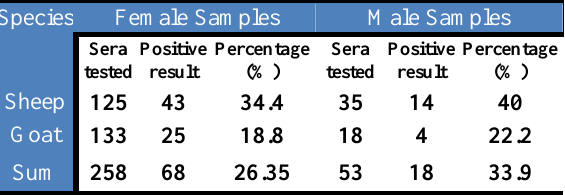
Table, 6: Percentage of sheep and goat brucellosis by using iELISA according to gender. Species